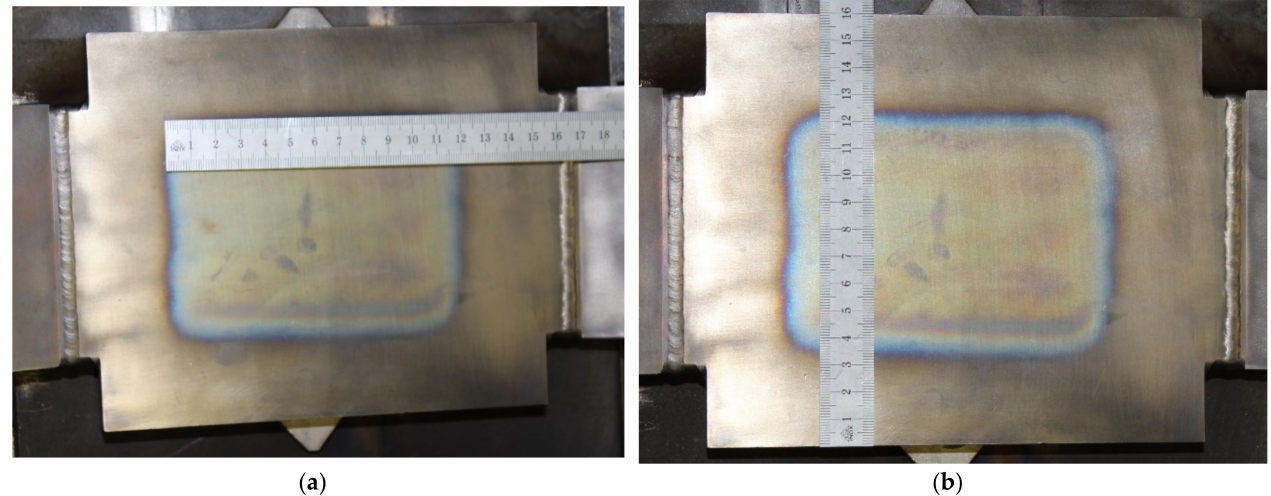
Figure 18. Status of the heat-loaded ODS mock-up surface after the testing, in both pictures the flow direction in the channels being from left to the right. The light-yellow area in the center of the picture indicates the zone subject to high-heat flux loading: ( a ) longitudinal measurement of the loaded area; ( b ) measurement of the mock-up transverse dimensions and of the loaded